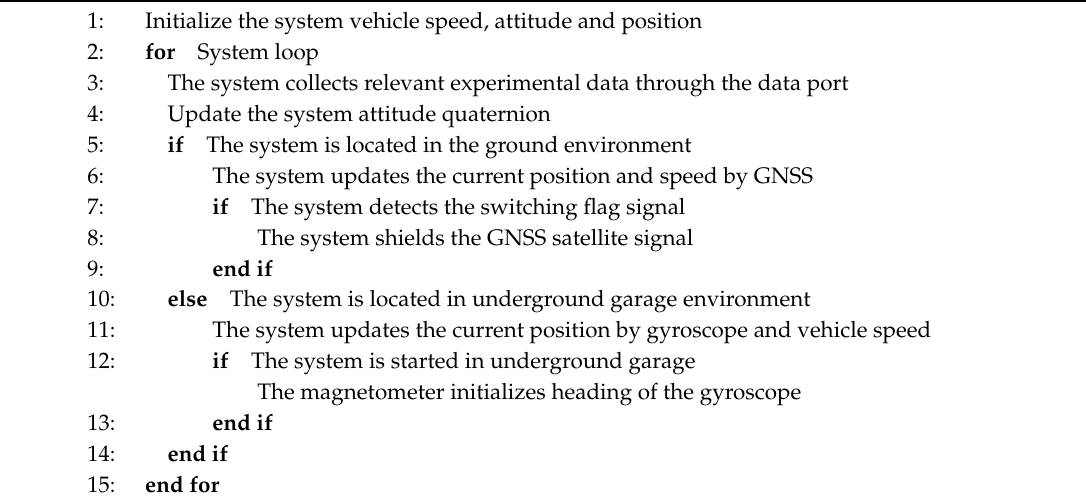
Algorithm 1: Operational process of the switching